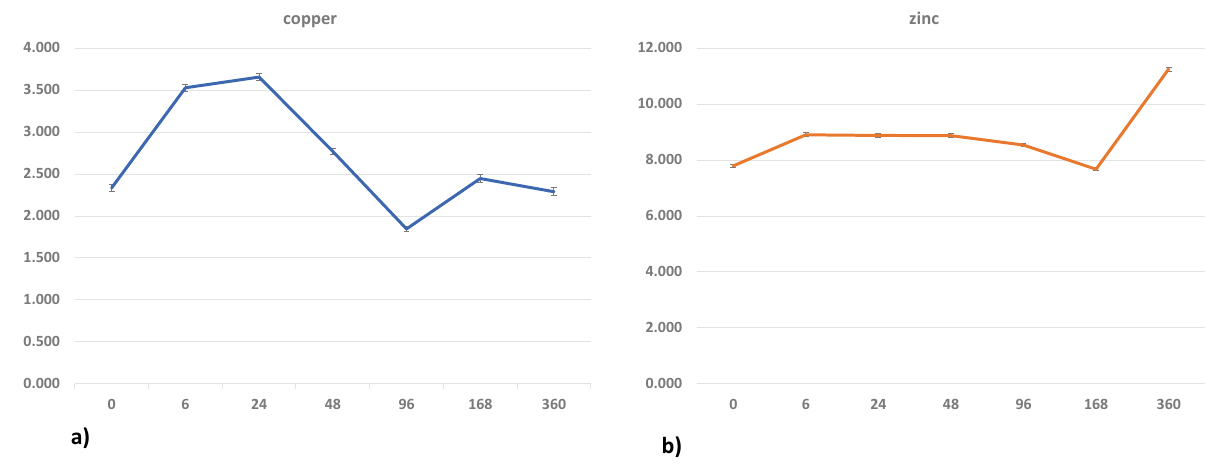
Figure 6. Time course of copper ( a ) and zinc ( b ) leaf concentrations at different intervals (expressed as hours in the graph) of 0, 0.25, 1, 2, 4, 7, and 15 days after DENTAMET injection. The mean and relative standard error refer to the two elements’ average concentrations, and the values are expressed as ppm (mg/kg of fresh